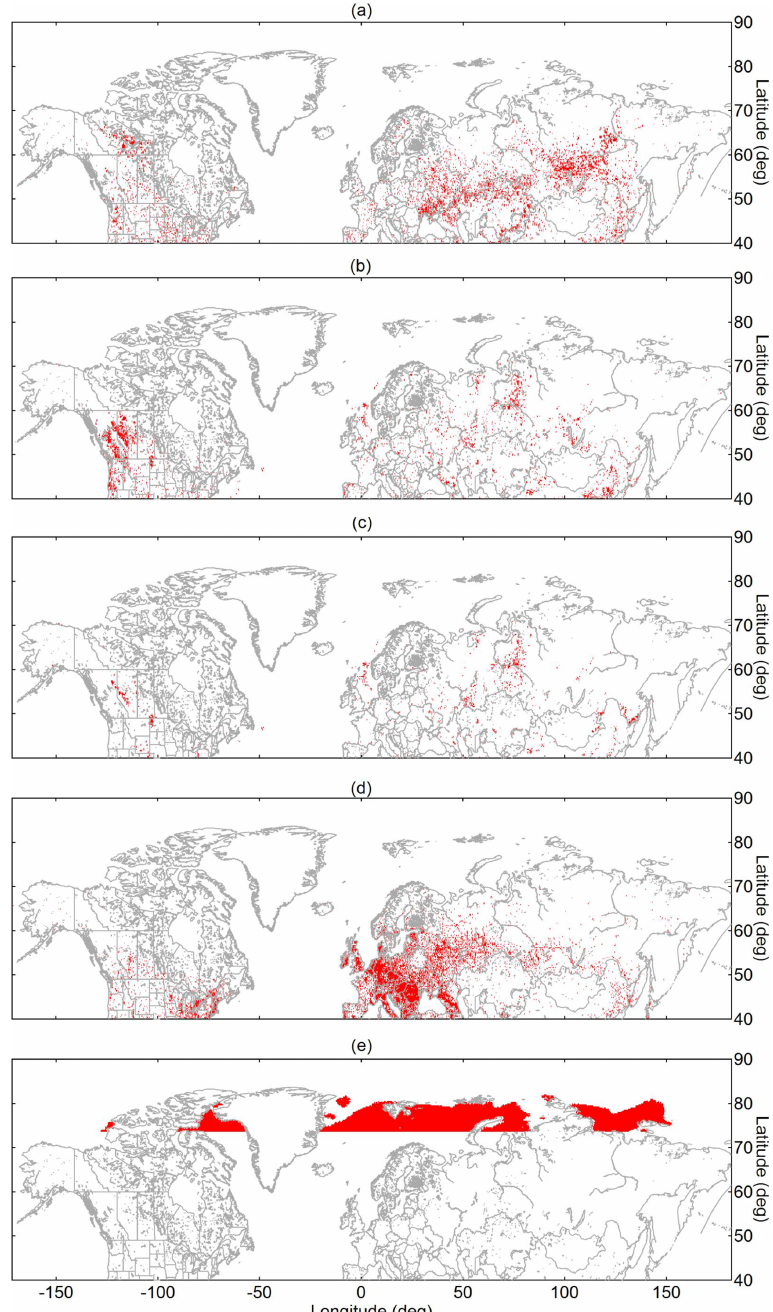
Figure 3. Map showing the geolocation of selected source sectors: (a) vegetation fires, (b) industry (including flaring), (c) flaring, (d) pop- ulation, and (e) Arctic open water. Panel (a) shows accumulated fires from 19 June to 21 July 2014. Red pixels indicate the presence of the respective source sector irrespective of the particular emission